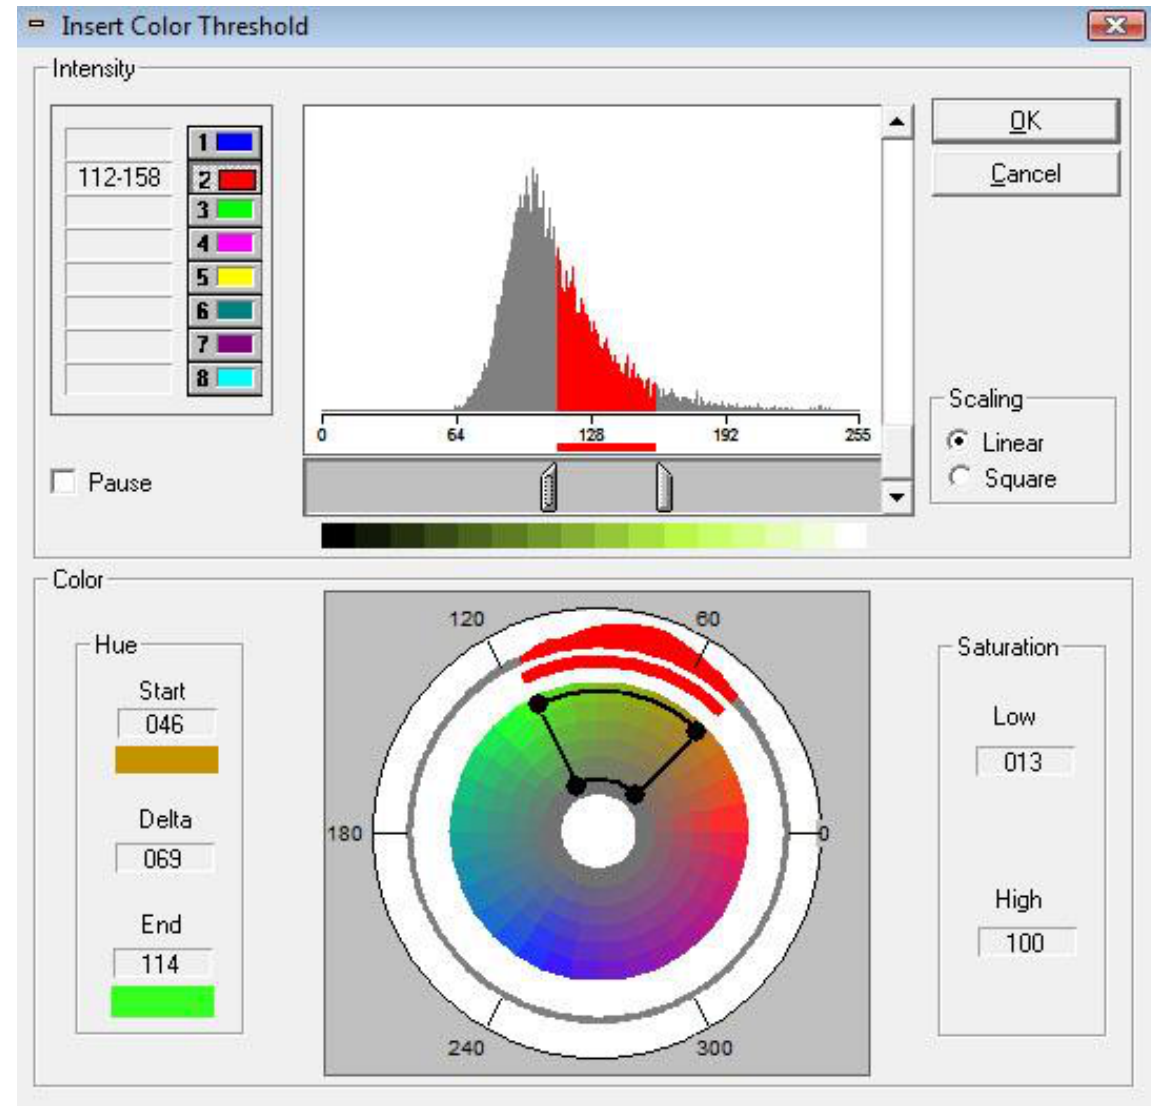
Figure 6: The Thresholding dialog box within